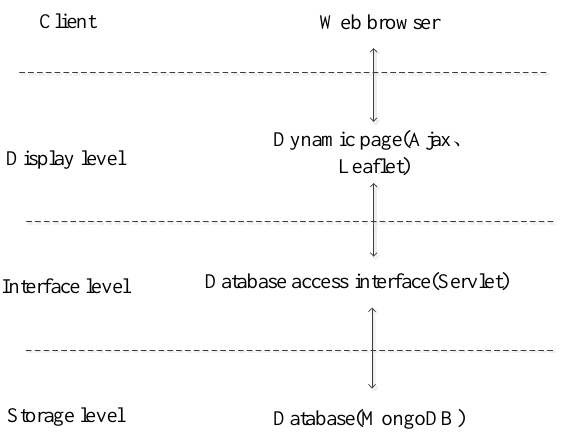
Figure 5. The architecture of the visualization system